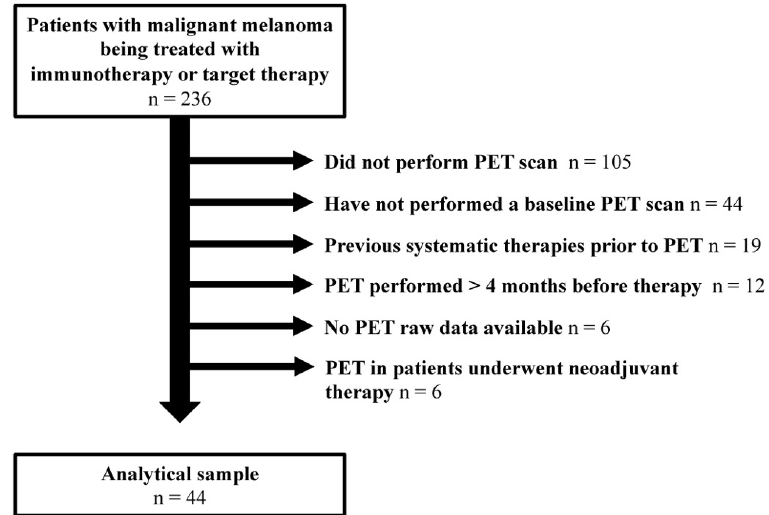
Figure 1. CONSORT DIAGRAM of patient inclusion/exclusion.